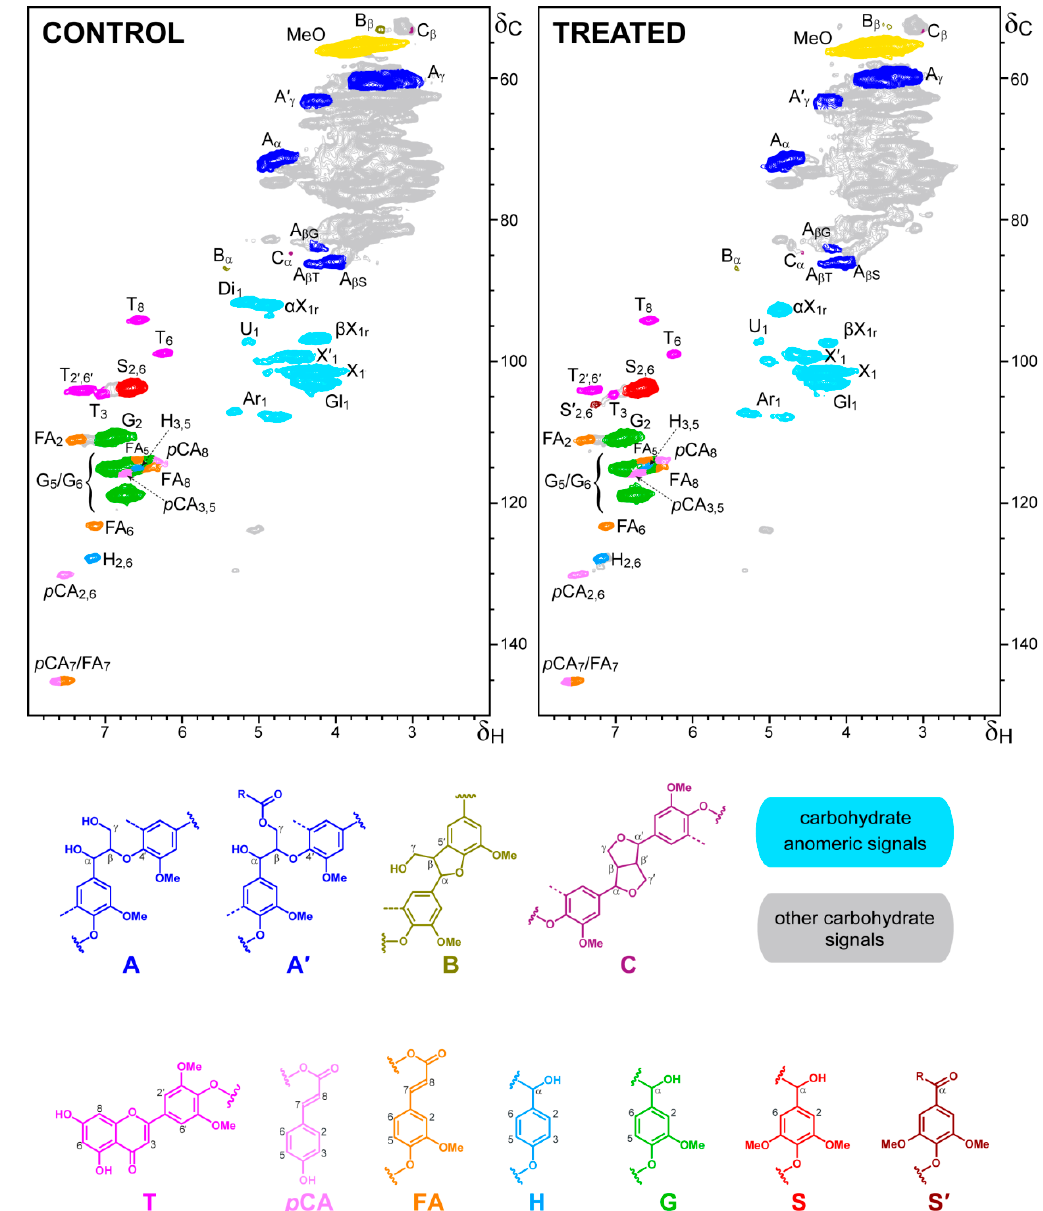
Figure 14. NMR analysis of control (uninoculated) wheat–straw and treated with P. eryngii for 43 days, acquired at the gel stage in DMSO- d 6 . Top. HSQC spectra displaying 13 C- 1 H cross-correlation signals of lignin, cinnamic acid, and carbohydrate moieties. Bottom. Lignin and other aromatic structures identified including: A , β – O –4 (cid:48) ether substructure (including a second S, G or T unit); A (cid:48) , γ -acylated β - O -4 (cid:48) ether substructure; B , phenylcoumaran substructure; C , resinol substructure; T , tricin substructure; p CA , p -coumaric acid; FA , ferulic acid; H , p -hydroxyphenyl unit, G , guaiacyl unit; S , syringyl unit; and S’ , C α -oxidized S unit (R in S’ can be a hydroxyl in carboxylic acids, a hydrogen in aldehydes, or a lignin side chain in ketones). For carbohydrates, only the anomeric signals were assigned corresponding to: Ar , arabinose units; Di , glucose moiety in disaccharide; Gl , glucose units; U , uronic acid units; X and X’ , normal and acetylated xylose units; and α Xr and β Xr , α and β xylose reducing